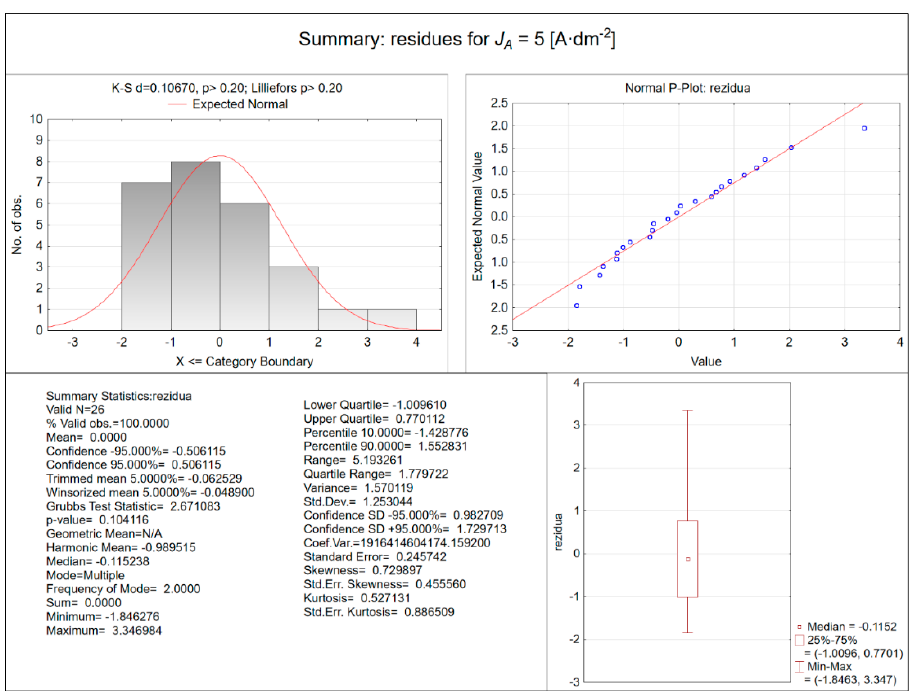
Figure 6. Analysis of residues as a demonstration for the current density of J A = 5 A ⋅ dm − 2 .